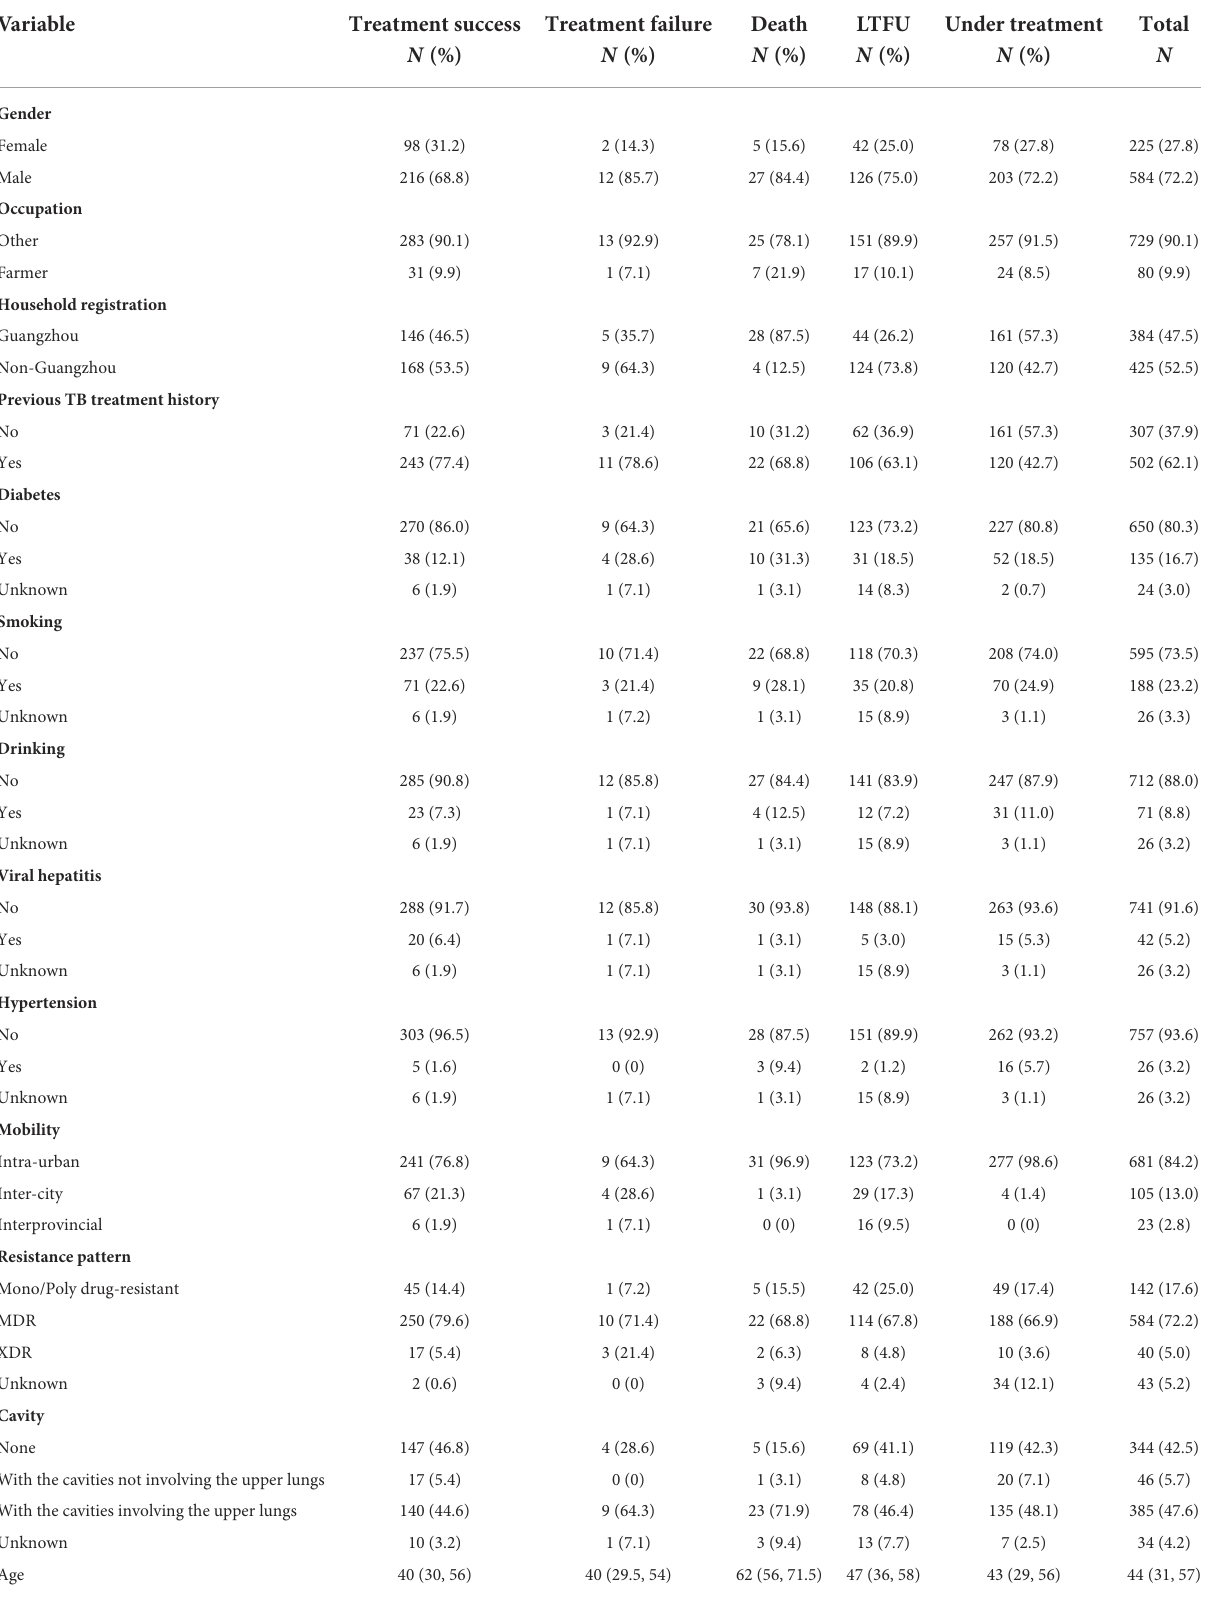
TABLE 2 Summary of patient characteristics and their treatment